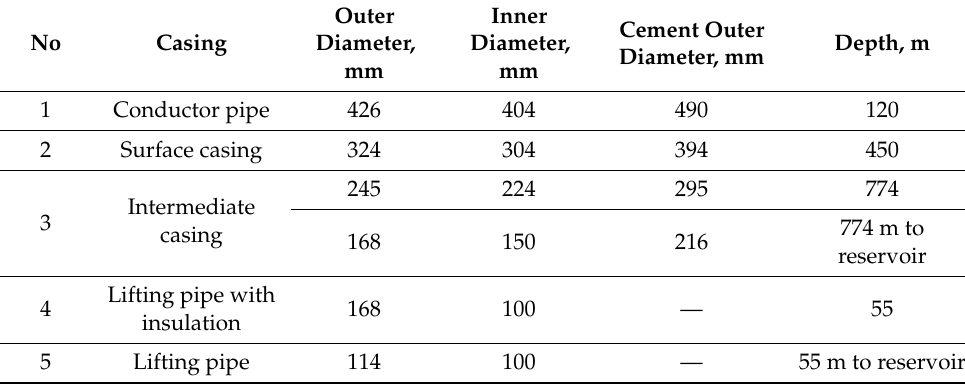
Figure 4. Model well completion used in simulations. Table 2. Parameters of a three-string producing